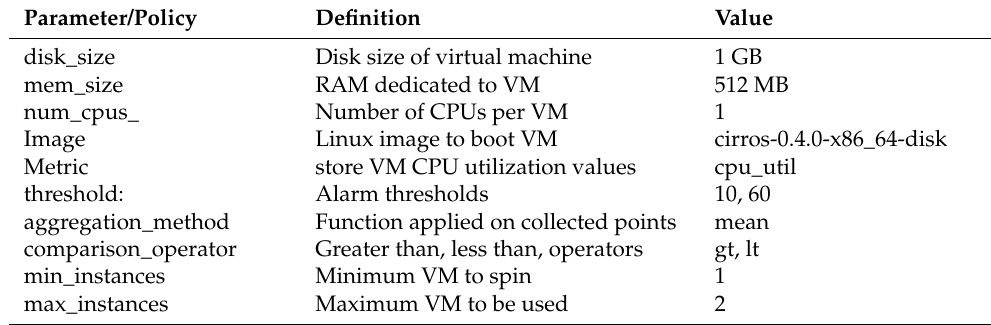
Table 3. VDU Parameters and Policies.